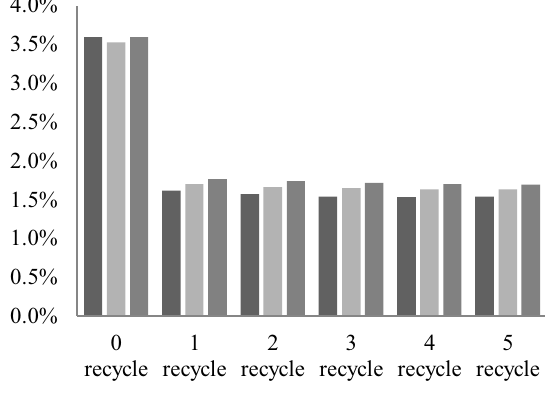
Fig. 10. 233 U feeding on each recycle (for each FA concepts).